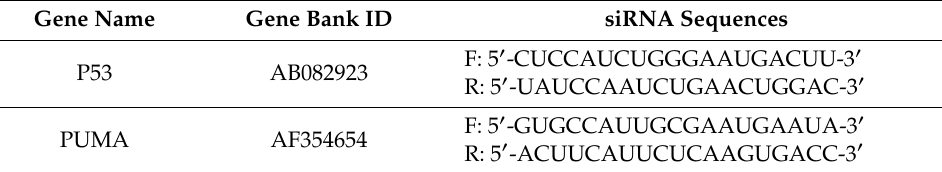
Table 1. Sequences for small (or short) interfering RNA (siRNA)